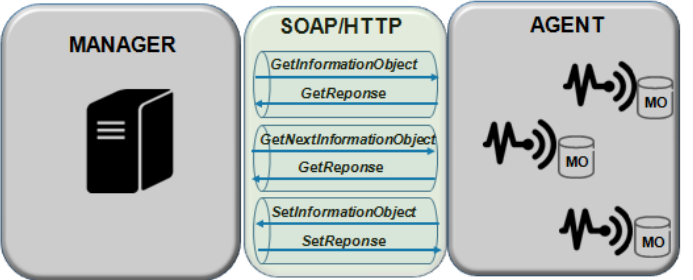
Figure 19. Illustration of the Things Management Protocol architecture.